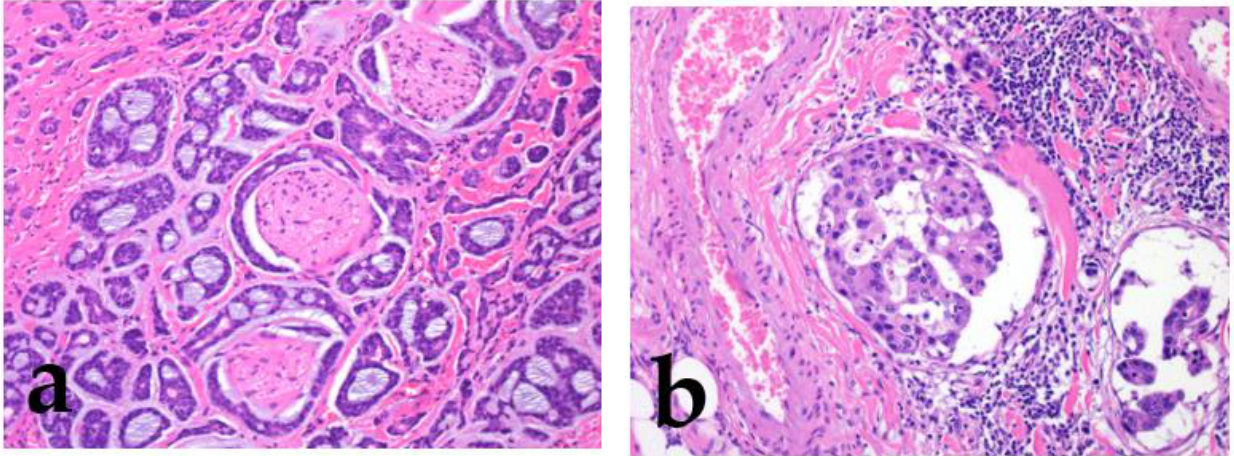
Figure 3. Perineural invasion and lymphatic invasion. Adenoid cystic carcinoma shows frequent perineural invasion ( a ), and salivary duct carcinoma shows lymphatic invasion ( b ).